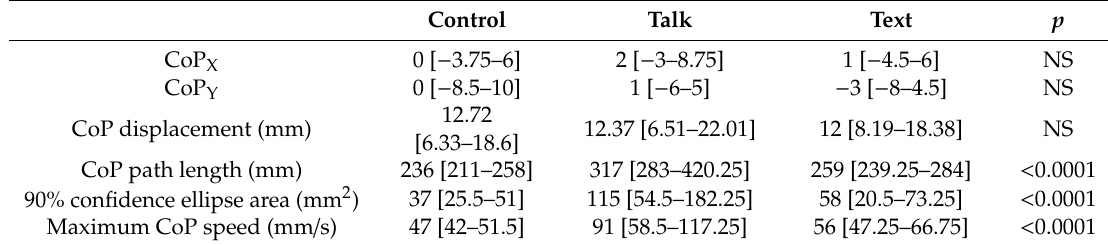
Table 3. Stabilometric data across the assessed conditions.